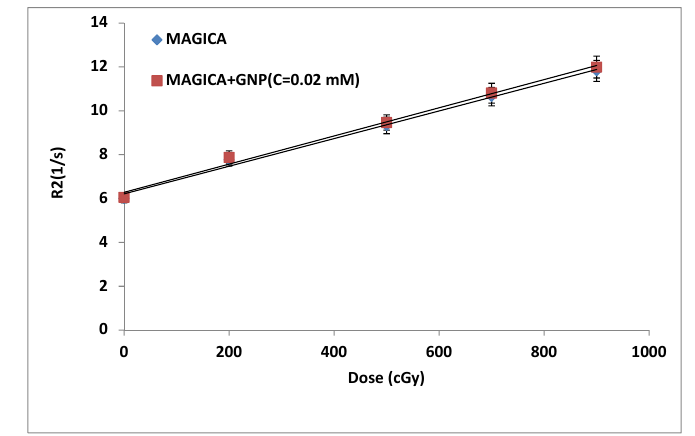
Fig. 5. Dose enhancement factor performed with MAGICA gel with 0.02 mM GNPs